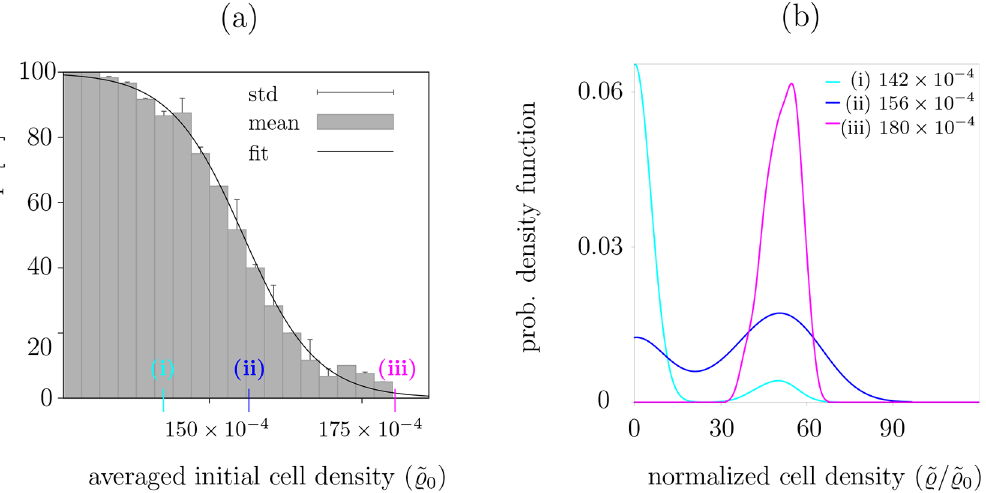
Fig 3. Frequency of population extinction in the CA model depends on the initial population size. (a) Stochastic fluctuations lead to extinction or growth. The figure shows the frequency of extinction events depending on averaged cell density ~ % ¼ j L j (cid:3) 1 by kernel density estimates, see S1 Text) of the averaged cell density after 5000 LGCA time steps for three different initial population densities. For each initial con fi guration 40 simulation runs are performed. Model parameters are κ = 4.4, θ = 0.75, r b = 0.2, r d = 0.01, K = 8. Cases (i), (ii) and (iii) refer to different initial population densities, which show bimodal (case (i) and (ii)) or unimodal (case (iii)) stationary size distributions.